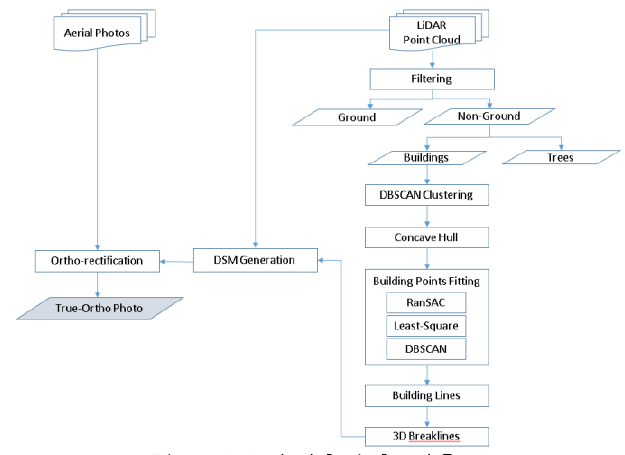
Figure. 1. Methodological workflow